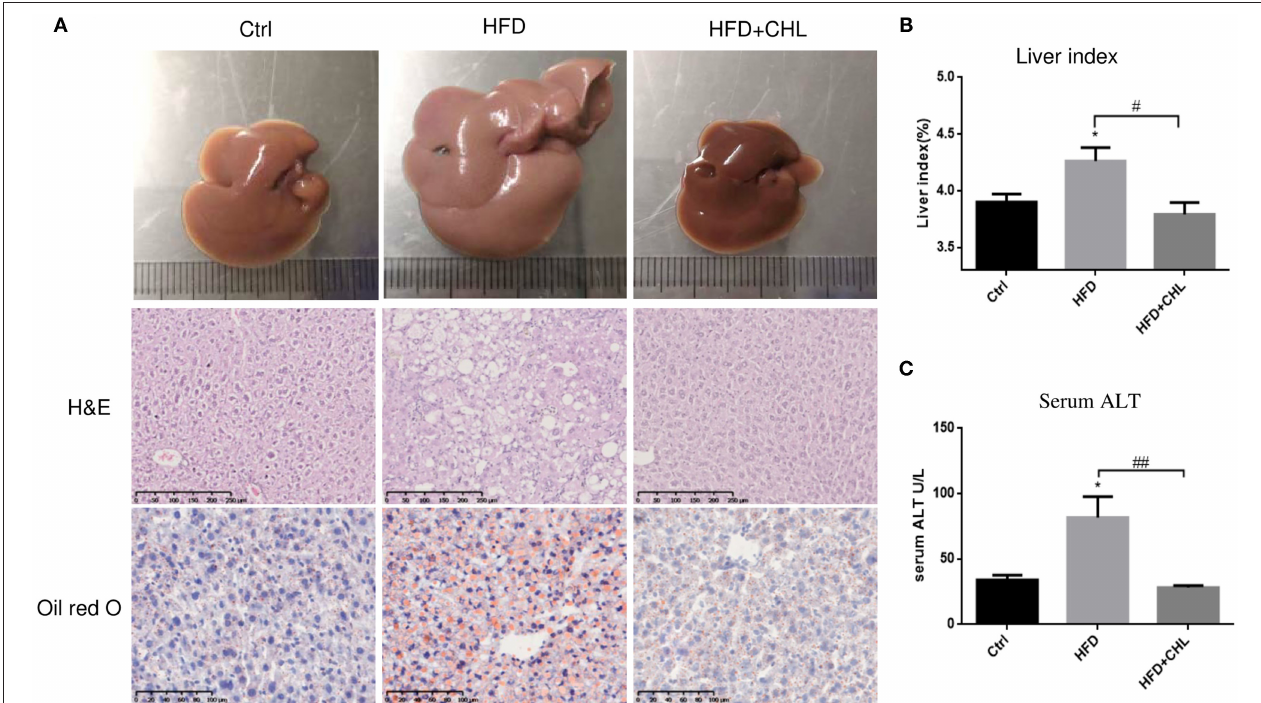
FIGURE 3 | CHL ameliorates hepatic steatosis and liver functions of the mice fed with an HFD. (A) The experimental condition is described in Figure 1 . In the end, images of the liver, histochemical staining by hematoxylin and eosin (HandE), and Oil Red O were determined. (B) Liver index, liver mass vs. body mass. (C) Serum alanine transaminase (ALT) levels and n = 6–8 for each group. Values are mean ± SEM; * p < 0.05 vs. Ctrl group; # p < 0.05, ## p < 0.01 vs. HFD group.